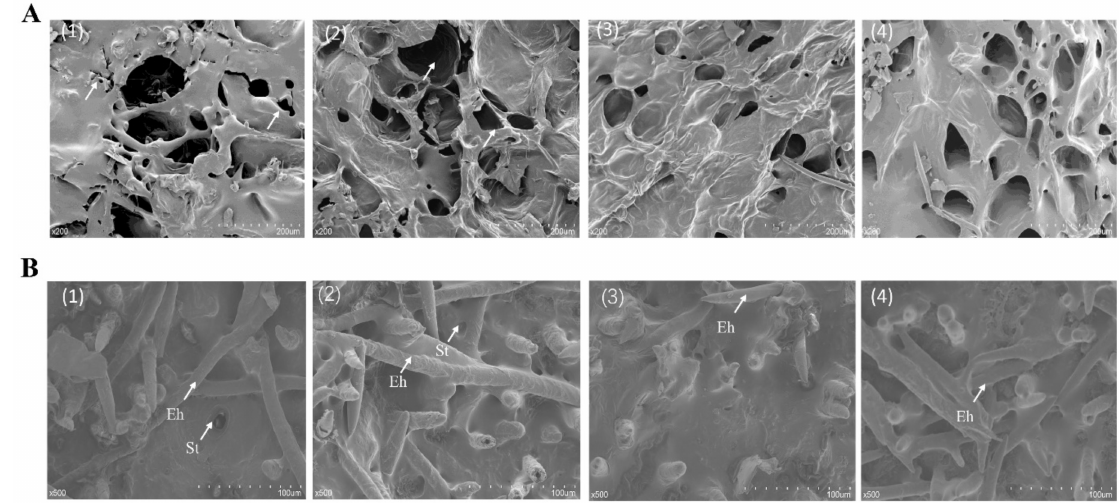
Figure 6. SEM images of di ff erent treatments on the flesh structure ( A ) and peel ( B ) of peach fruit on the 60th day. ( 1 ) CK; ( 2 ) LFT; ( 3 ) LFT + O 3 ; ( 4 ) LFT + TiO 2 . The stomata and epidermis of peach skin are represented by St and Eh,